Question: Briefly state, in one sentence, what is plotted here.
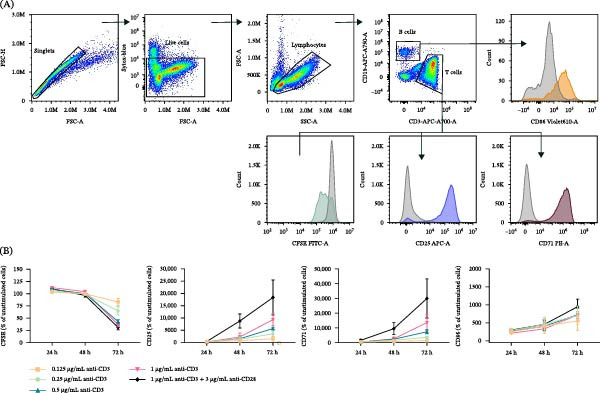
Answer: (A) Representative gating strategy of T‐cell screening assay. Human PBMCs were first gated to exclude doublets (FSC‐H vs. FSC‐A), followed by gating on live cells using a viability dye. Lymphocytes were gated based on their characteristic scatter patterns. Within the lymphocyte gate, T cells (CD3 + CD19 − ) and B cells (CD19 + CD3 - ) were distinguished. T‐cell activation and proliferation were assessed by median fluorescent intensity (MFI) analysis of CD71, CD25, and CFSE, while B‐cell activation was evaluated by CD86 expression. (B) Assay optimization. PBMCs were stimulated with different concentrations of anti‐CD3/anti‐CD28 and proliferation and activation were measured at different time points (24, 48, 72 h). Orange: 0.125 µg/mL anti‐CD3; green: 0.25 µg/mL anti‐CD3; blue: 0.5 µg/mL anti‐CD3; pink: 1 µg/mL anti‐CD3; black: 1 µg/mL anti‐CD3 + 3 µg/mL anti‐CD28. Data are expressed as percentage of unstimulated PBMCs (set to 100%) and are presented as median ± SD of three independent experiments ( n = 3), each performed with 12 technical replicates.